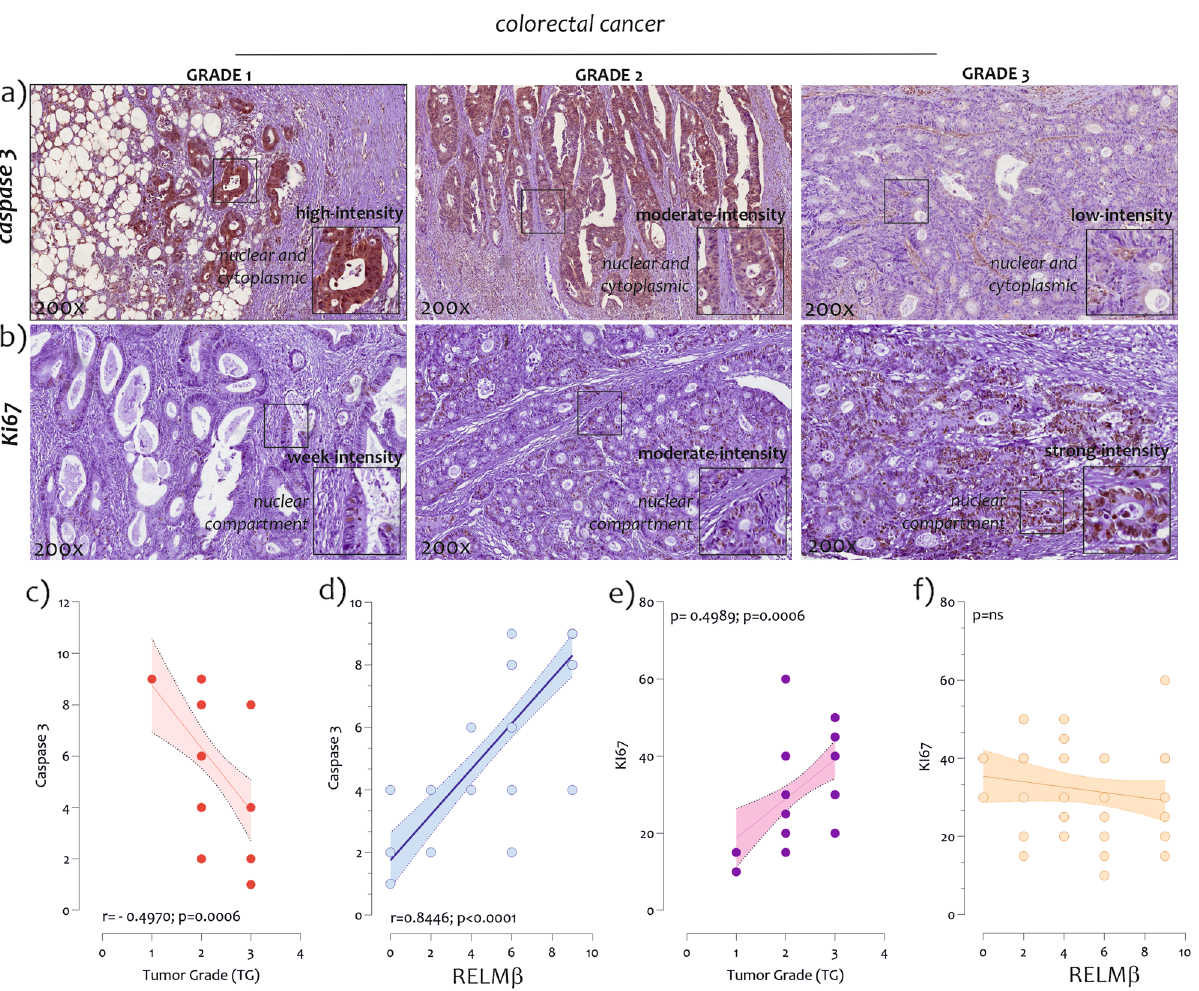
Figure 8. Caspase 3 and KI67 protein detection in CRC biopsies from G1, G2, and G3 grade. ( a ) Immunostaining of Caspase 3 in G1, G2, and G3 CRC biopsies; ( b ) Immunostaining of KI67 3 in G1, G2, and G3 CRC biopsies; ( c ) Caspase 3 and tumor grading correlation; ( d ) Caspase 3 and RELMβ correlation; ( e ) KI67 and tumor grading correlation; ( f ) KI67 and RELMβ correlation. The boxes represent magnification of the original figure. Immunoreactivity Score (IRS) was obtained by multiplying IS and ES and it was considered as low (L-IRS), if < 6, and as high (H-IRS), if ≥ 6,